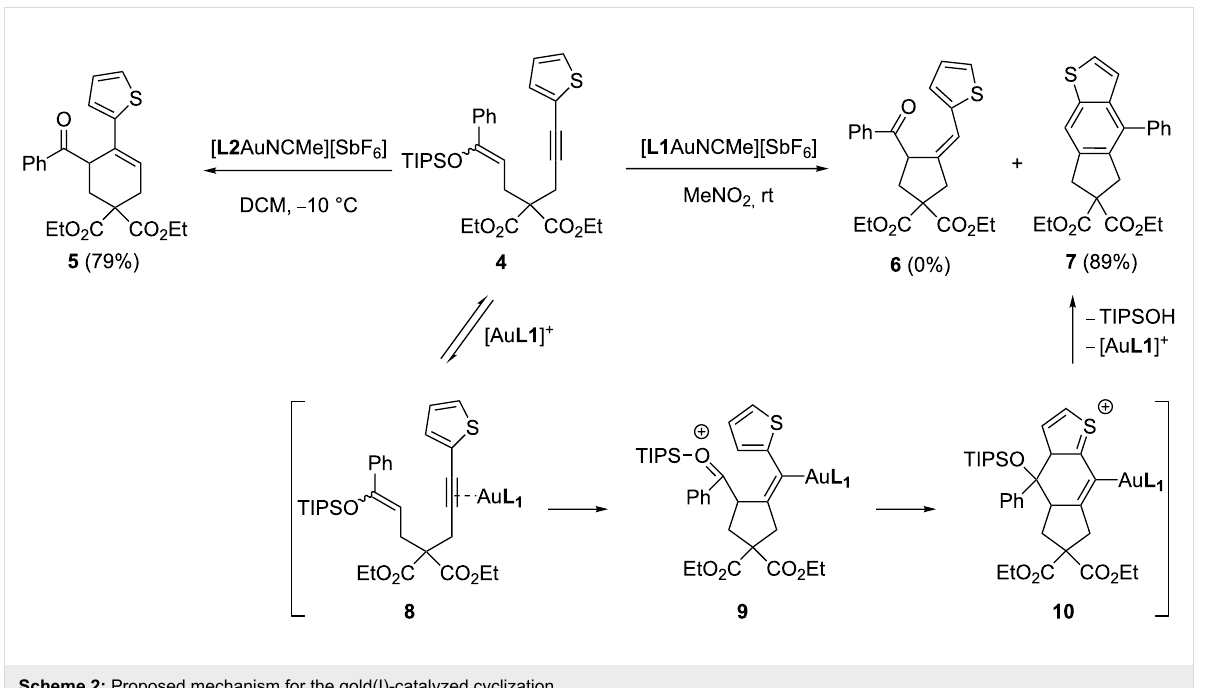
Scheme 2: Proposed mechanism for the gold(I)-catalyzed cyclization.